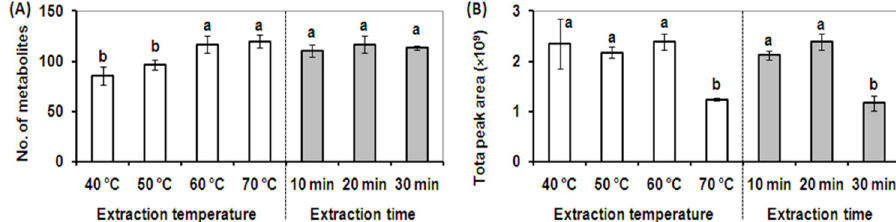
Figure 2. Effect of temperature and extraction time on SPME extraction performance. ( A ). The total number of volatile metabolites detected at different extraction temperatures for 20 min (white column) and different extraction times at 60 ◦ C using a DVB/CAR/PDMS SPME fiber (gray column). ( B ). The total peak area of metabolites detected at different extraction temperatures for 20 min (white column), and different extraction times at 60 ◦ C using a DVB/CAR/PDMS SPME fiber (gray column). Vertical bars with the same letter are not significant; however, those indicated with a different letter are significant according to the Duncan’s multiple range test ( p < 0.05). These results illustrate that the broadest cross-section of volatile and semi-volatile metabolites was detected using an extraction temperature of 60 °C and an extraction time of 20 min.